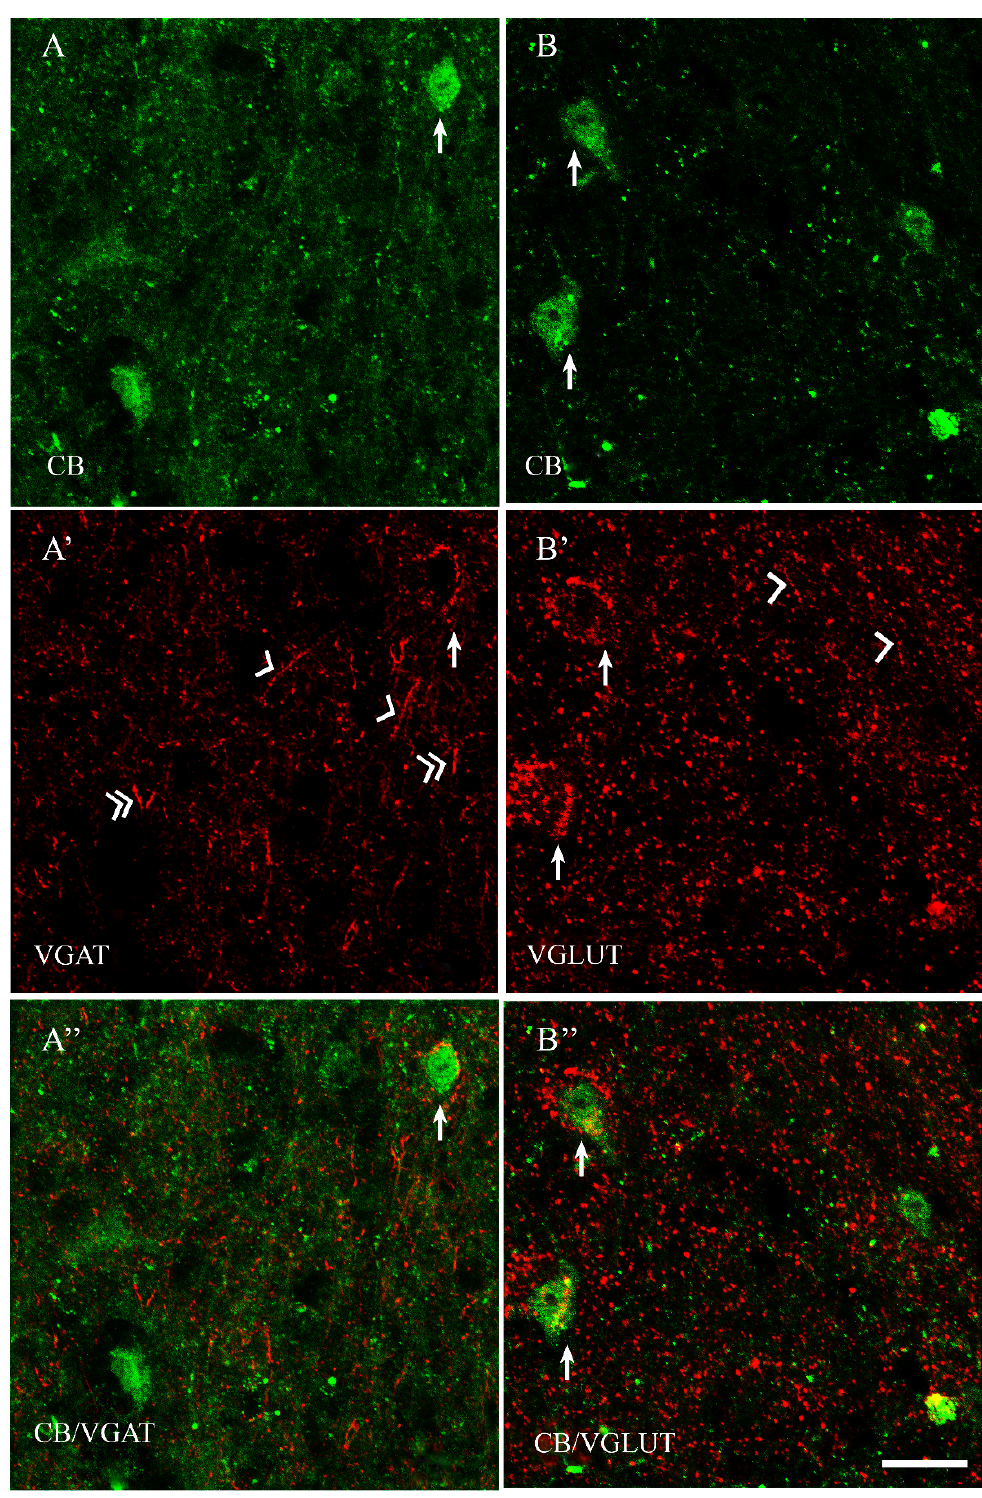
Figure 2. Double-labeling confocal immunofluorescence illustrating the anatomical relationships between CB+ neurons and VGAT ( A – A” ) as well as CB+ neurons and VGLUT ( B – B” ) in the periventricular preoptic nucleus of the guinea pig. Arrows show CB+ neurons that were simultaneously VGAT+ ( A – A” ) and/or VGLUT+ ( B – B” ); arrowheads indicate varicose dendrites; double-arrowheads indicate smooth dendrites. Scale bar = 20 μ m.